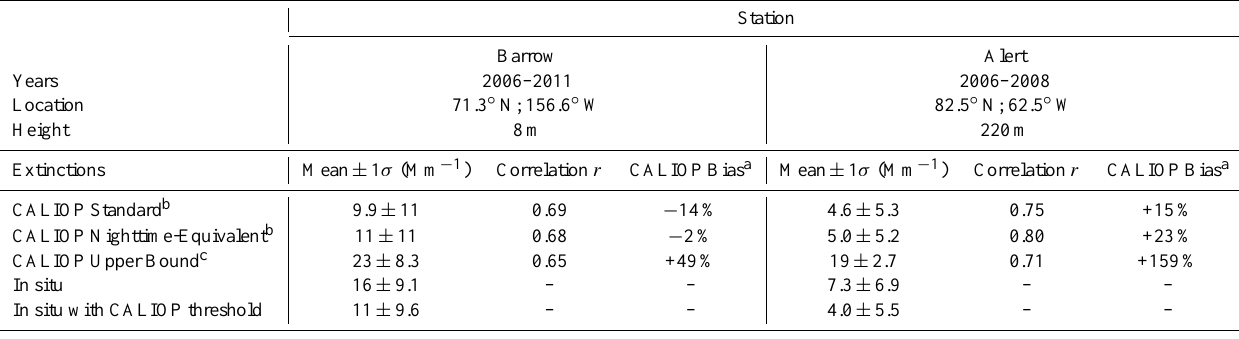
Table 1. Summary of in situ and CALIOP extinctions at Barrow and